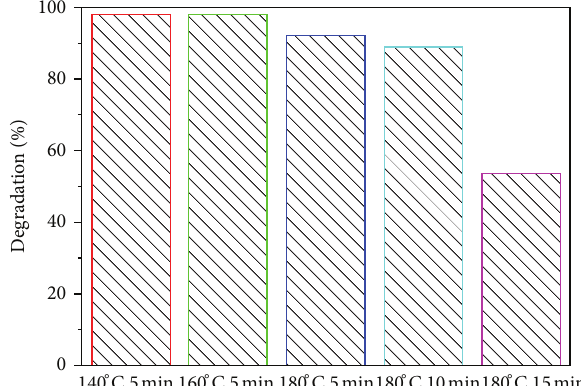
Figure 8: The activity of ZnWO 4 for photodegradation of RhB under a different reaction